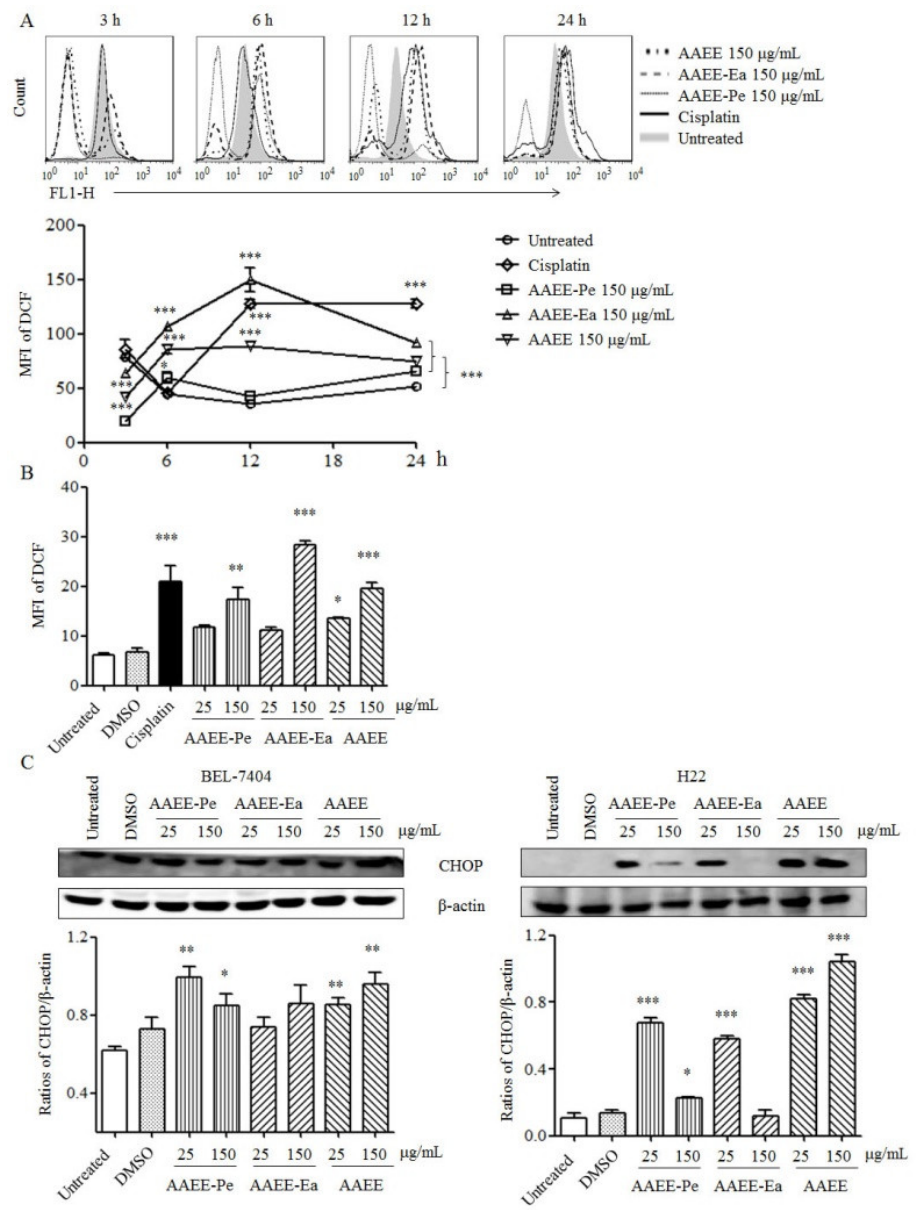
Figure 5. AAEE, AAEE-Pe, and AAEE-Ea induced ROS generation and ER stress. ( A ) BEL-7404 cells were treated with 150 μg/mL of AAEE, AAEE-Pe, and AAEE-Ea and the levels of ROS were analyzed by flow cytometry at indicated time points. ( B ) H22 cells were treated with different concentrations of AAEE, AAEE-Pe, and AAEE-Ea for 24 h and the levels of ROS were analyzed by flow cytometry. ( C ) BEL-7404 and H22 cells were treated with different concentrations of AAEE, AAEE-Pe, and AAEE-Ea for 24 h. Cell lysates were used to analyze the levels of CHOP by Western blot. * p < 0.05; ** p < 0.01; *** p < 0.001 compared to